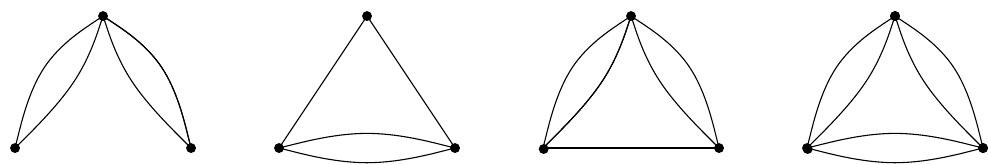
Figure 1. Four graphs G 1 , G 2 , G 3 , G 4 such that each G i is uncoverable by less than m ( G i ) odd